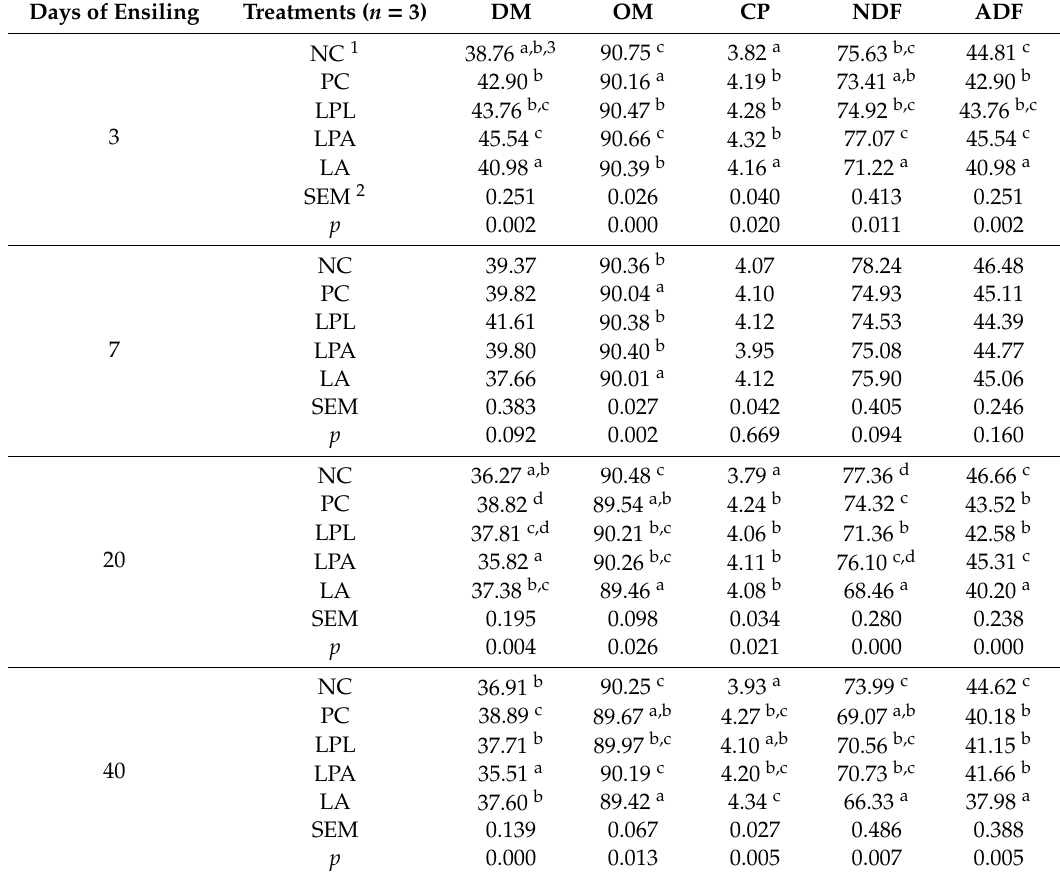
Table 4. E ff ect of di ff erent starter cultures on chemical composition (%) of rice straw silage (dry matter basis unless otherwise